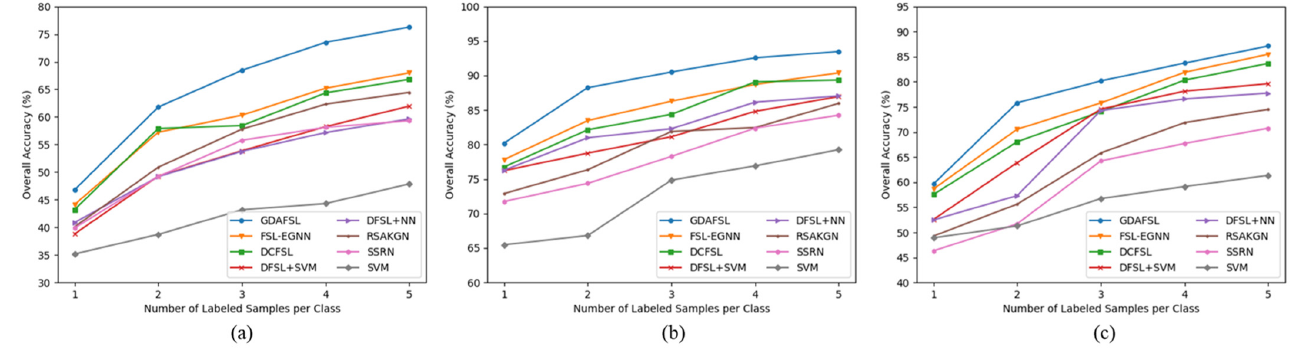
Figure 17. OA (%) of eight HSI classification methods with various labeled sample sizes on three target datasets. ( a ) IP. ( b ) UP. ( c ) SV.